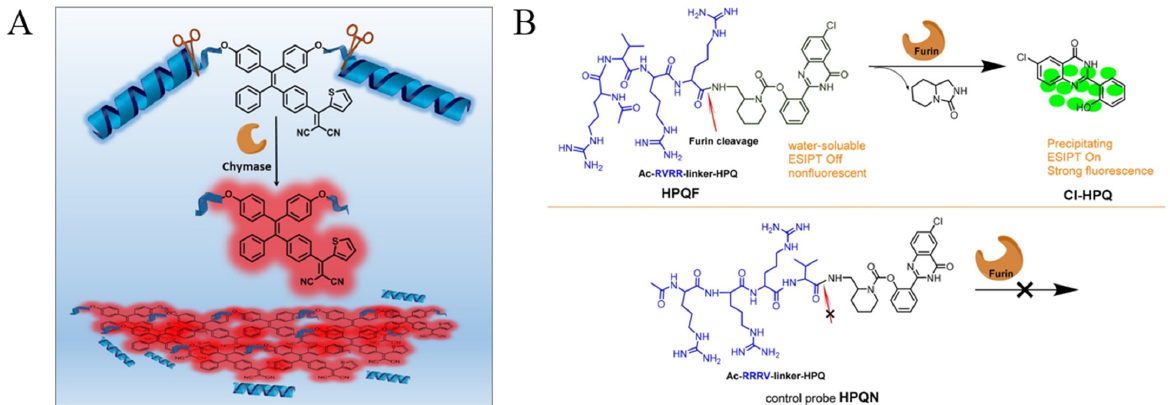
Figure 1. ( A ) Schematic illustration of the functional mechanism of the probe TPETH-2(CFTERD n ). n = 2 or 3 for chymase sensing. Reprinted with permission from ref. [42]. Copyright 2016,